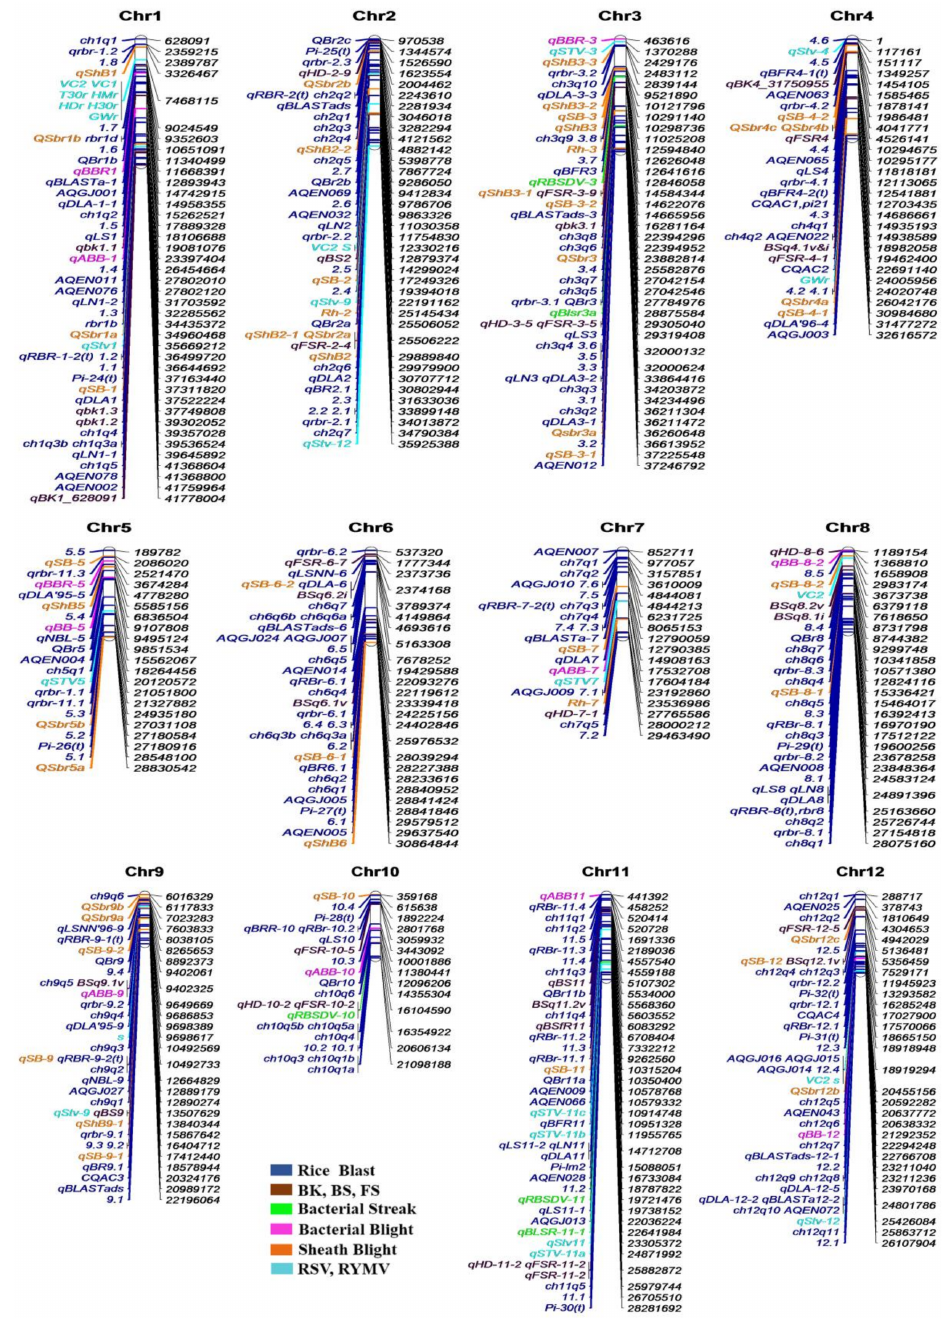
Figure 4. QTLs distribution on rice chromosomes. Separate color codes are given for each group of QTLs. The physical distribution of QTLs is derived by the nearest linked molecular markers on each chromosome. BK, BS, FS, RSV and RYMV represent Bacterial Streak, Brown Spot, False Smut, Ricestripe virus and Rice yellow mottle virus resistance QTLs,